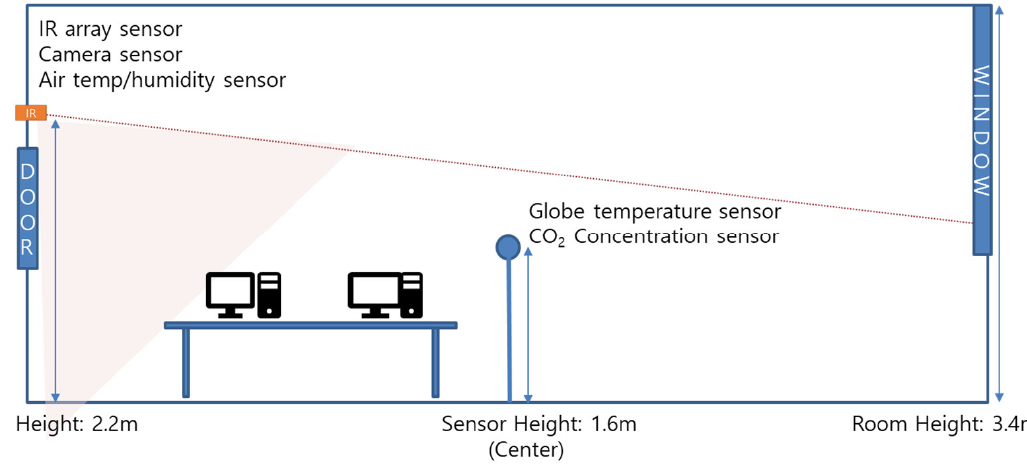
10 of 30 Table 2. Sensors. Characteristic